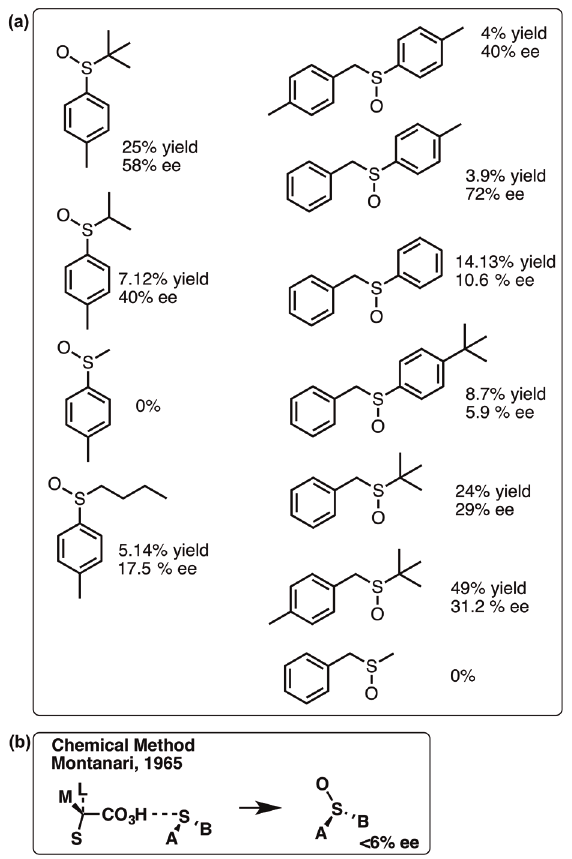
Figure 5 - Sulfoxides studied by Auret et al. (Auret et al. 1966) ( a ) and the chemical oxidation with (+)-percamphoric acid described by Montanari (1965) ( b